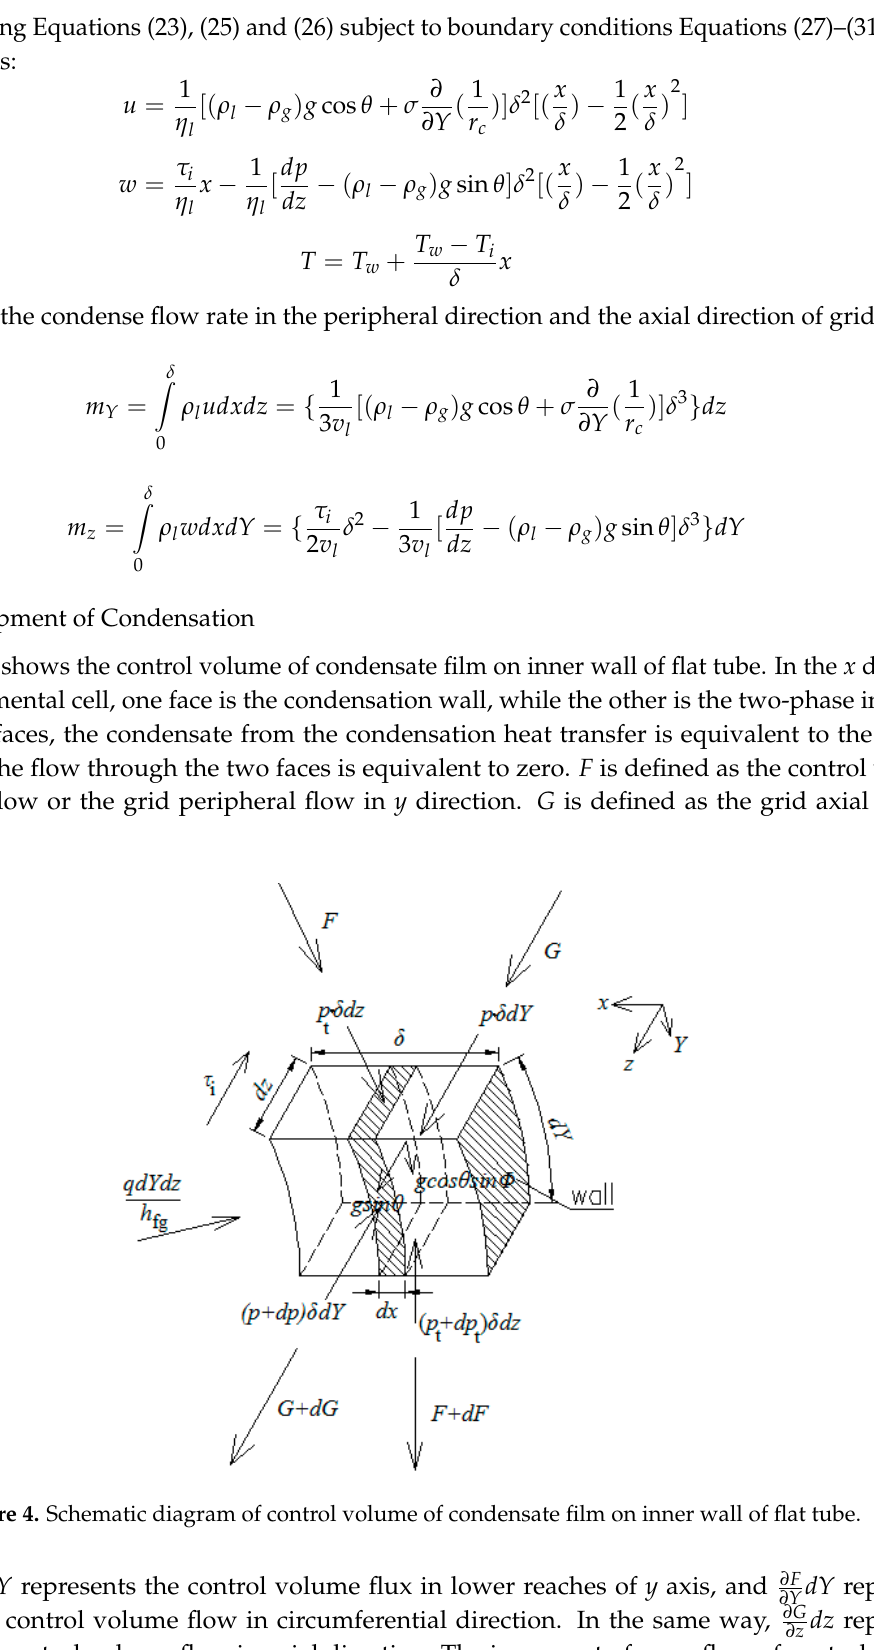
dY represents ∂ Y dz represents ∂ z